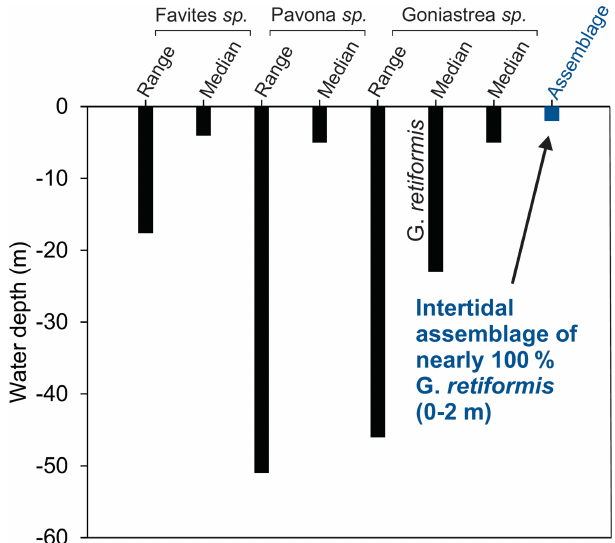
Figure 5. Comparison of approaches for interpreting sample pa- leowater depth based on modern coral depth distributions and reef assemblages for LIG fossil reef outcrops in the Seychelles. Modern depth distributions for the genera Favites , Pavona and Goniastrea (all of which are found in primary growth position in the Seychelles outcrops) are shown by the black bars in terms of the median and total depth range (95% confidence; OBIS, 2014). The blue bar is the paleowater depth interpretation for an intertidal assemblage that grew in 0–2m water depth based on facies interpretations of the fos- sil reef outcrops and comparison to modern reef analogues (Dutton et al.,